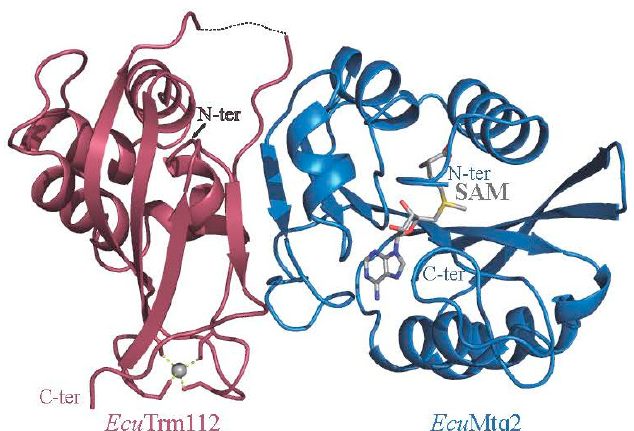
Figure 4. Ribbon representation of the crystal structure of the Encephalitozoon cuniculi ( Ecu ) Mtq2-Trm112 complex bound to SAM (grey sticks).